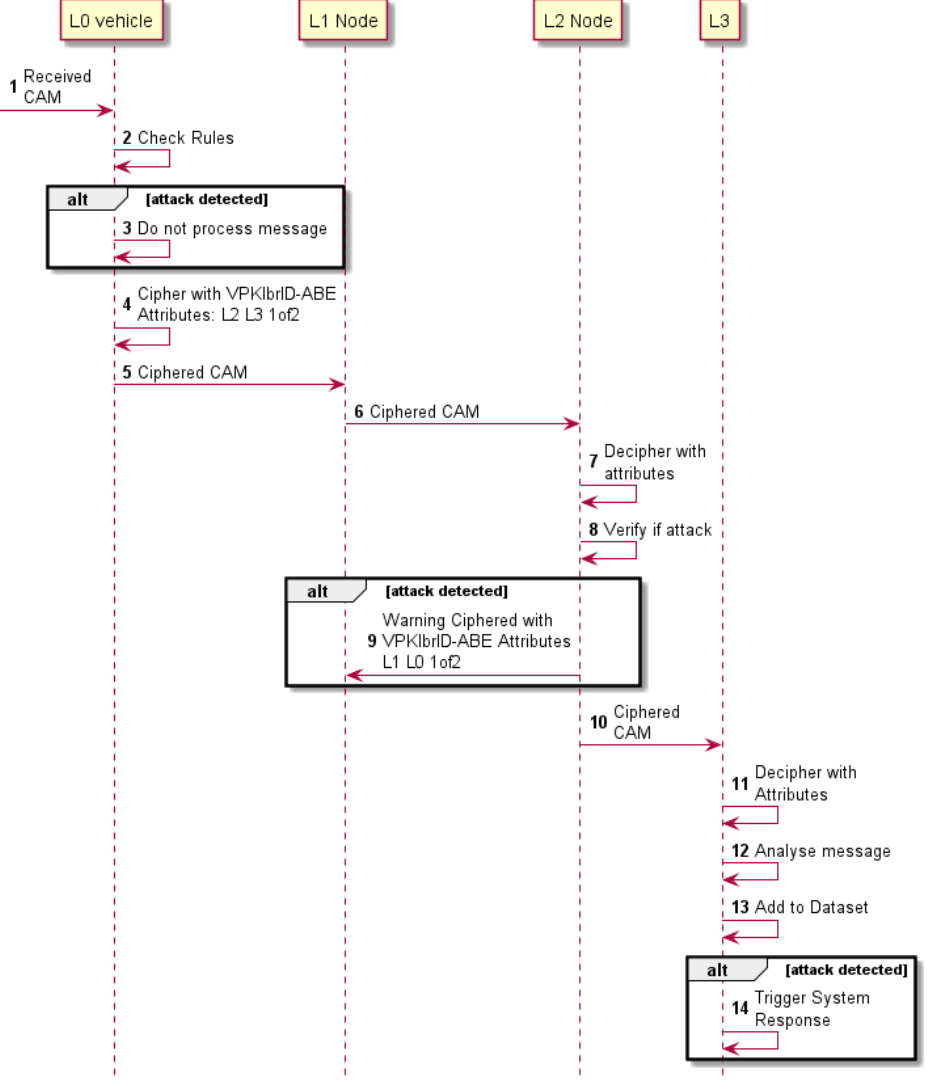
Figure 4. CAM upstream communications and